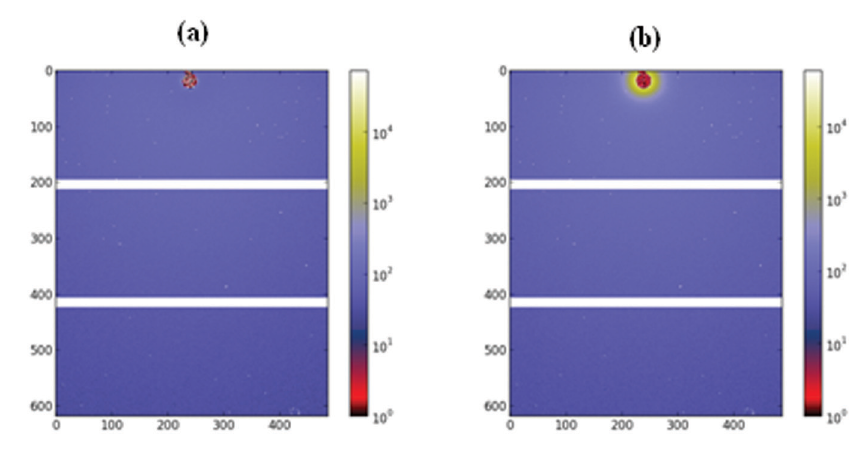
Figure 5. SAXS 2D patterns of: (a) PHB thermo-compression molded film and (b) PHB nanofibers